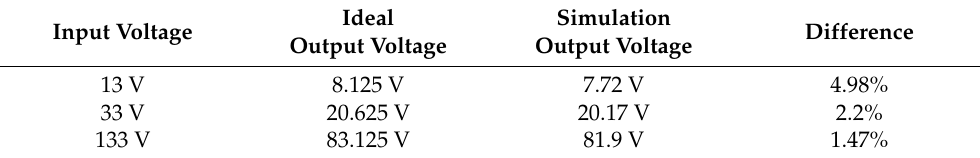
Table 4. Simulation results considering parasitic capacitance.